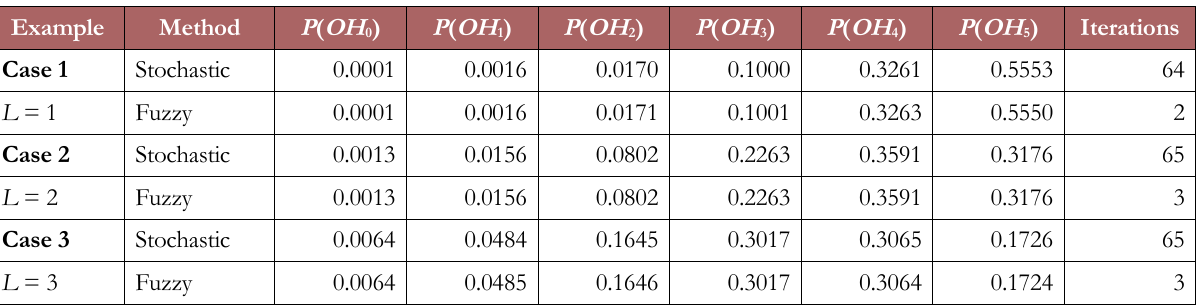
Table 1. Comparison of the and the number of iterations when R = 4, S = 5 and ε =